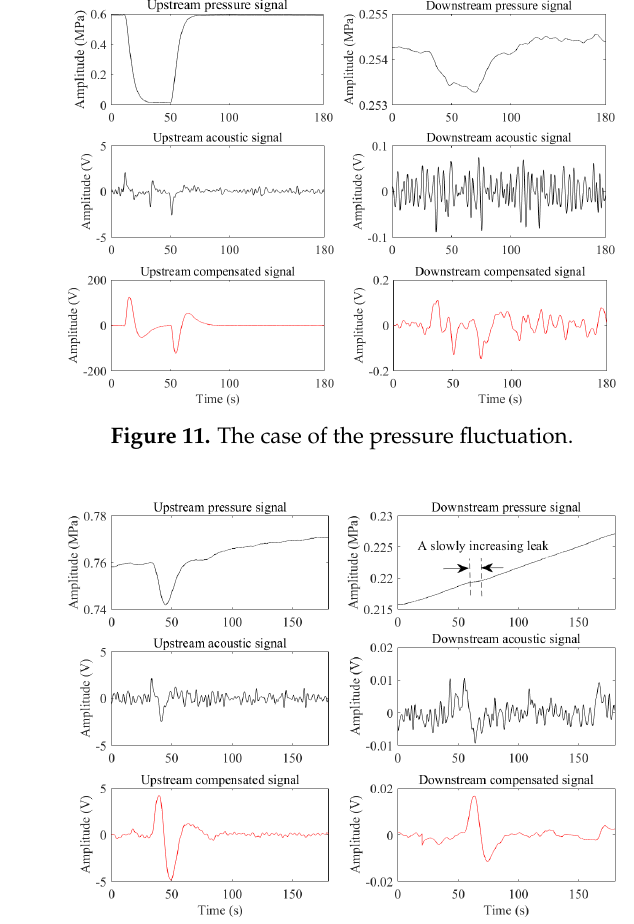
Figure 12. The case of the pressure